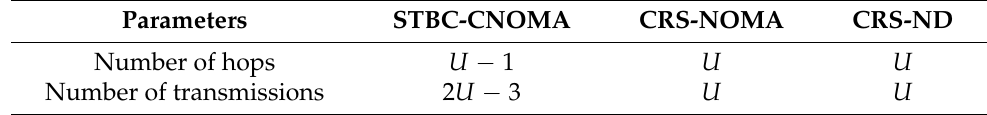
Figure 7. Symbol error probability of STBC-NOMA with imperfect SIC, and perfect timing synchro- nization over Rayleigh and Rician fading channels for U = (4, 6, and 8), and with K = 4 dB. Table 1. A comparison of different cooperative schemes in